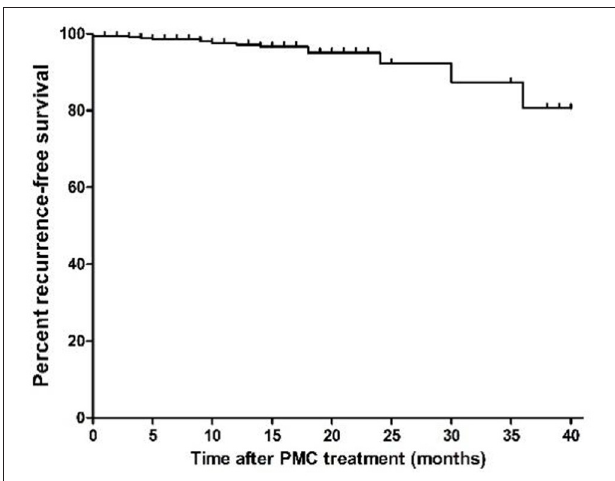
FIGURE 2 | Kaplan–Meier recurrence-free survival curves for patients who underwent percutaneous microballoon compression (PMC) treatment.